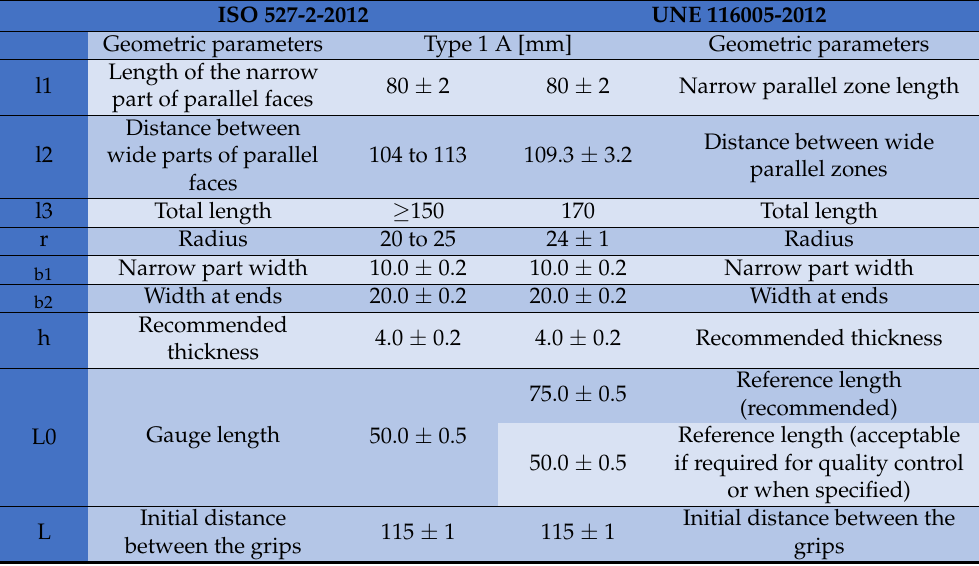
Table 2. Specifications for 1A samples according to ISO 527-2: 2012 and UNE 116005: 2012.